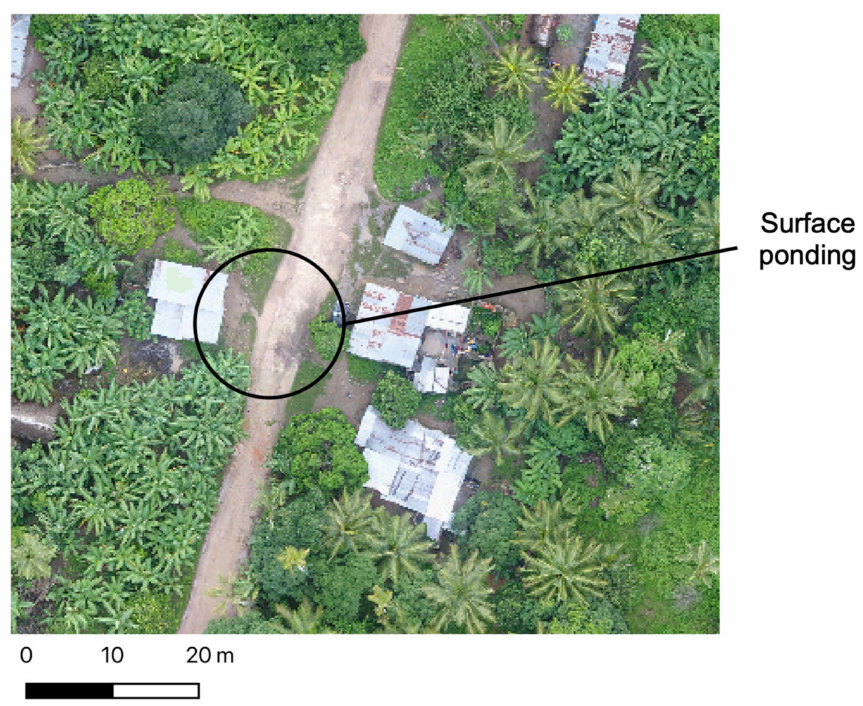
Figure 3. Surface ponding occurring in a track evident in drone imagery over Miwani. Although similar in colour to surrounding soil, the smooth texture of the feature and its relatively distinct edges make it a candidate for digitizing as a potential breeding